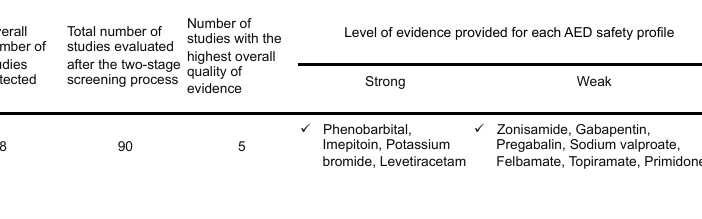
Figure 3: Staircase of AED’s safety profile hierarchy Direct comparisons suggested that imepitoin and levetiracetam might have a better safety profile than phenobarbital, whilst the latter might have a better safety profile than potassium bromide. However, none of these comparisons showed a statistically significant difference . Comparisons between other AEDs were not possible due to lack of relative comparison studies. Individual AED assessments indicated that levetiracetam might be one of the safest AEDs, followed by imepitoin and then phenobarbital and potassium bromide. The safety profile in other AEDs was variable.